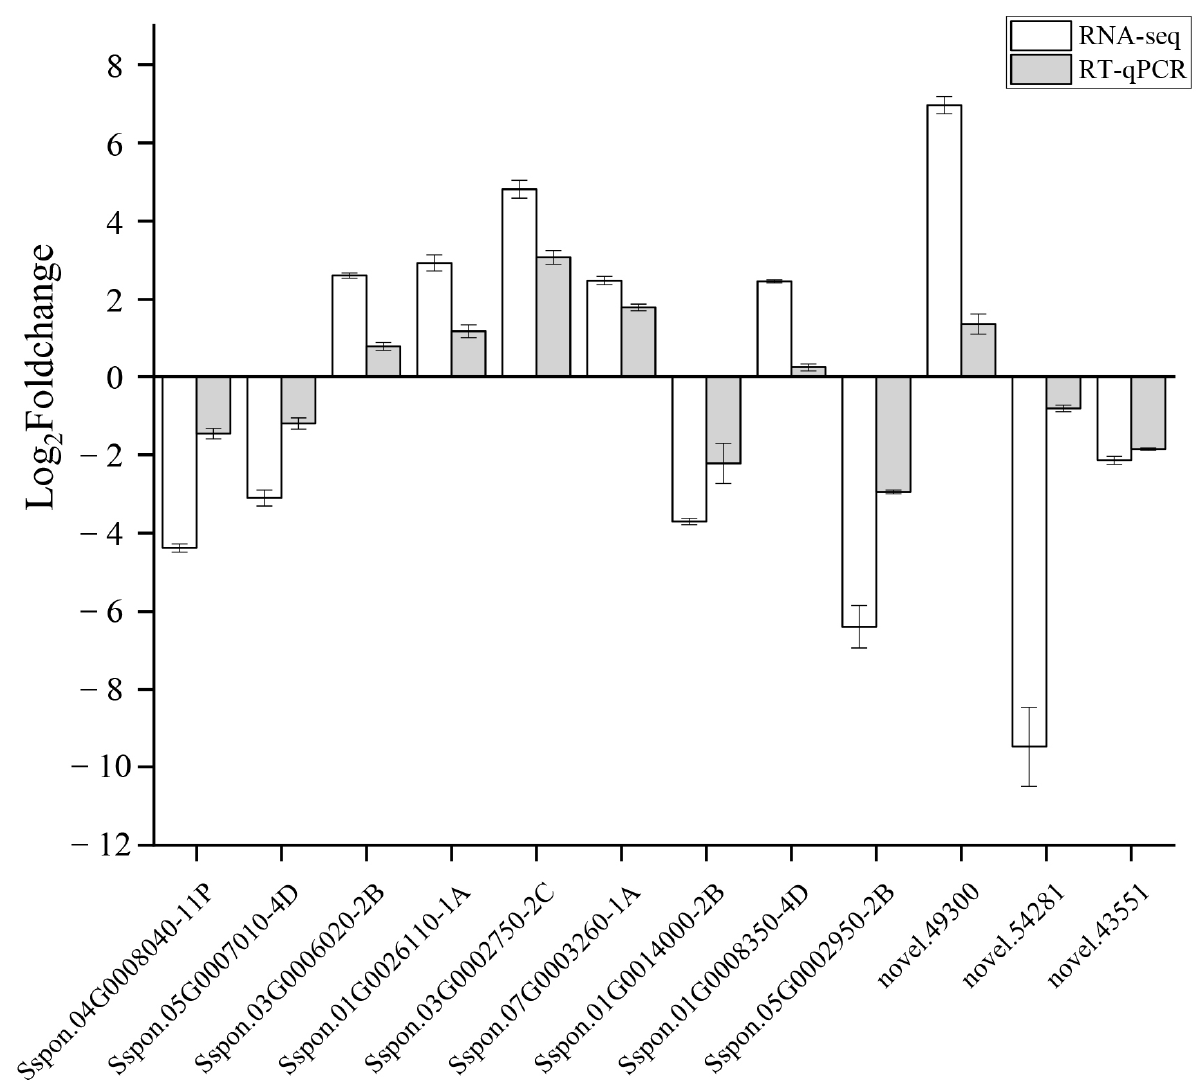
Figure 3. Results of RNA-seq and RT-qPCR for 12 genes. The gene expression level of RNA-seq shows as Log 2 (fold change) and the fold-change is based on the FPKM values of drought stress group relative to control group. The gene expression level of RT-qPCR shows as Log 2 (fold change = 2 −ΔΔ Ct ).